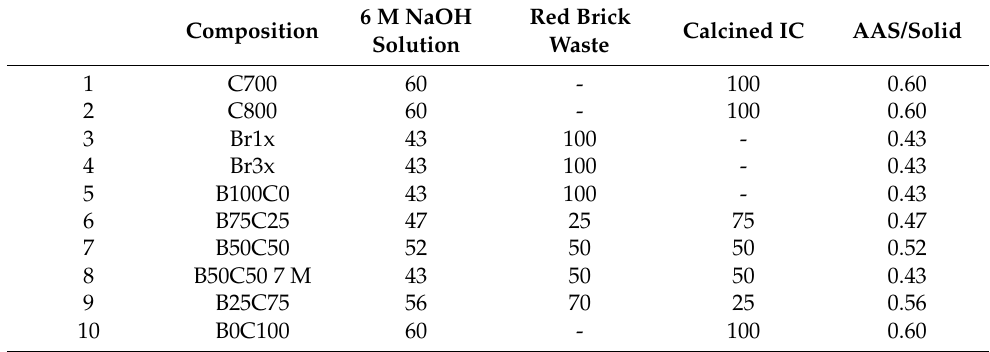
Table 2. AAM compositions based on heat-treated IC and ground red brick waste precursors, wt.%. 6 M Composition